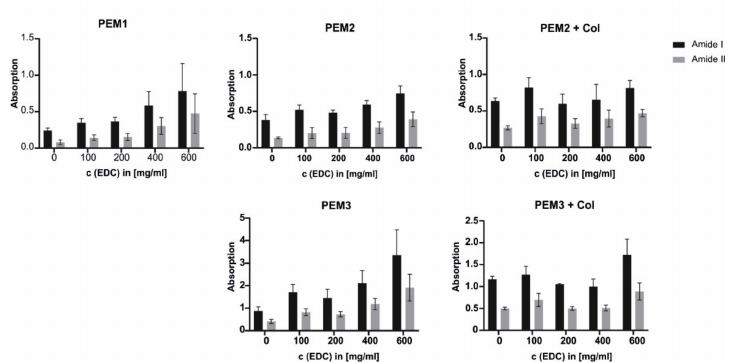
Figure 3. Absorption of ATF-FTIR spectra of native and cross-linked PEM films. The values (amid I and amid II) reflect the maximum from two characteristic peaks within the measured spectra. Each peak represents one specific amide bond formed within the film after contact with EDC. The height of the peaks correlates with the number of amide bonds.